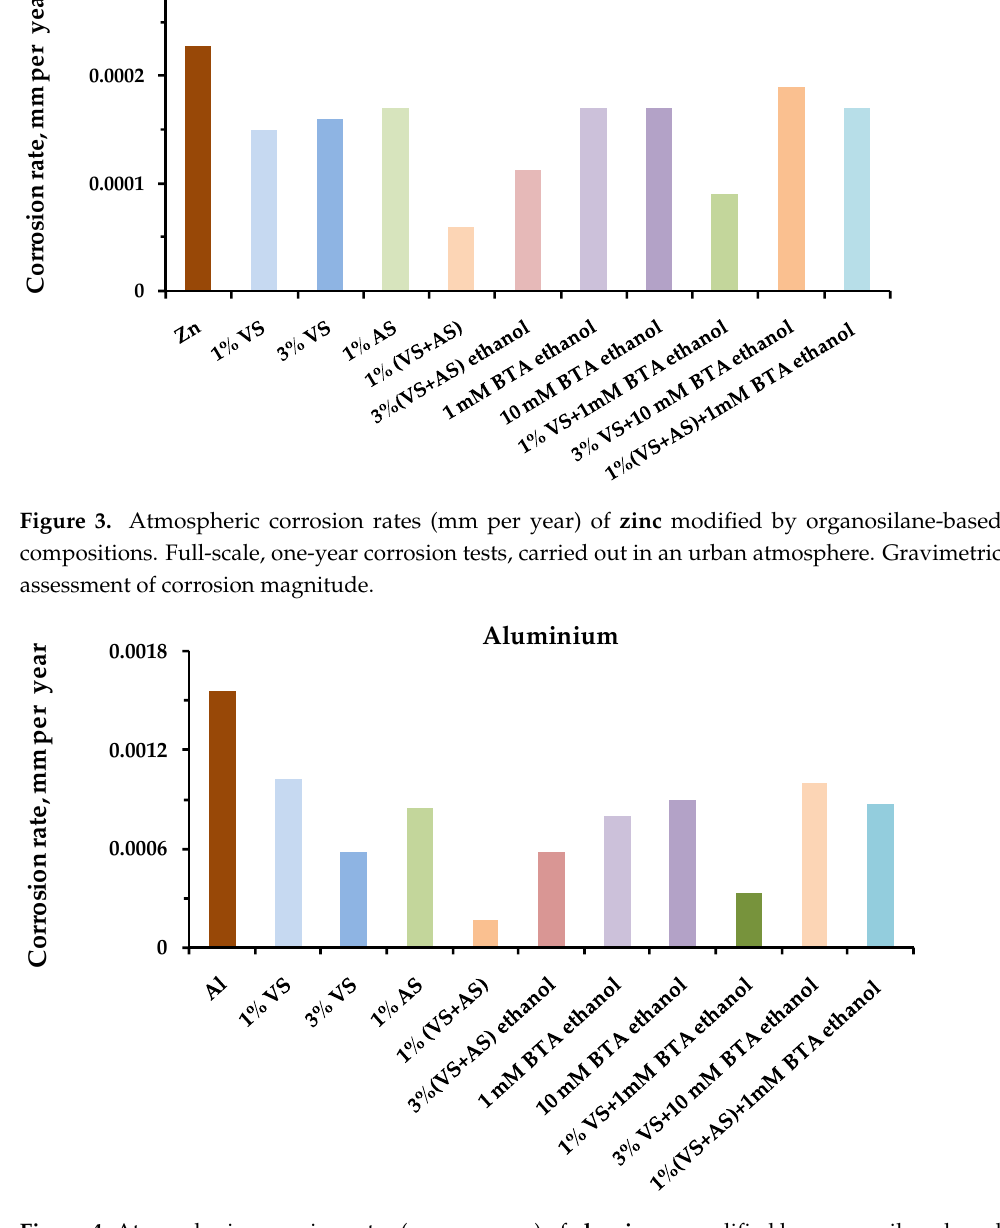
Figure 4. Atmospheric corrosion rates (mm per year) of aluminum modified by organosilane-based compositions. Full-scale, one-year corrosion tests, carried out in an urban atmosphere. Gravimetric assessment of corrosion magnitude.